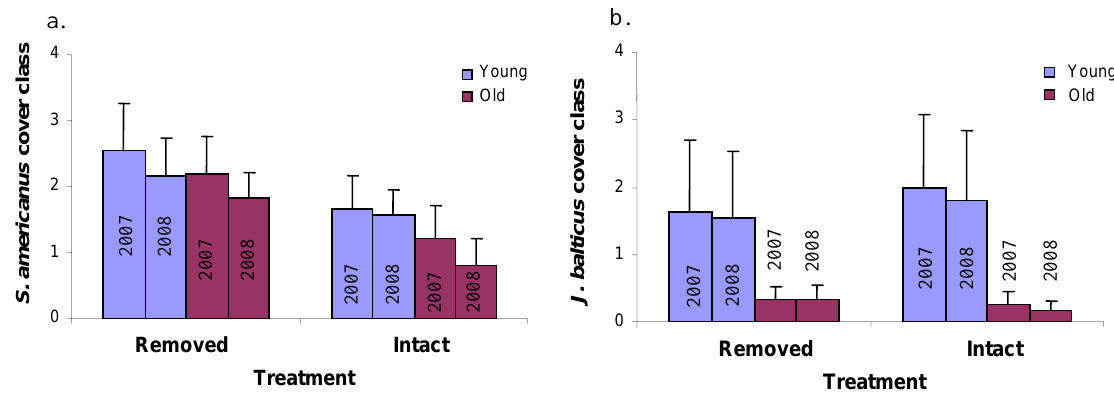
Figure 4. Average cover class of Schoenoplectus americanus (a) and Juncus balticus (b) in 2007 and 2008, 1 and 2 years after perennial pepperweed removal, in young and old strata, where perennial pepperweed was either removed or left intact. Cover classes 1–4 correspond to <1%, 1–5%, 6–15%, and 16–25% cover, respectively. Bars are ±95% confidence